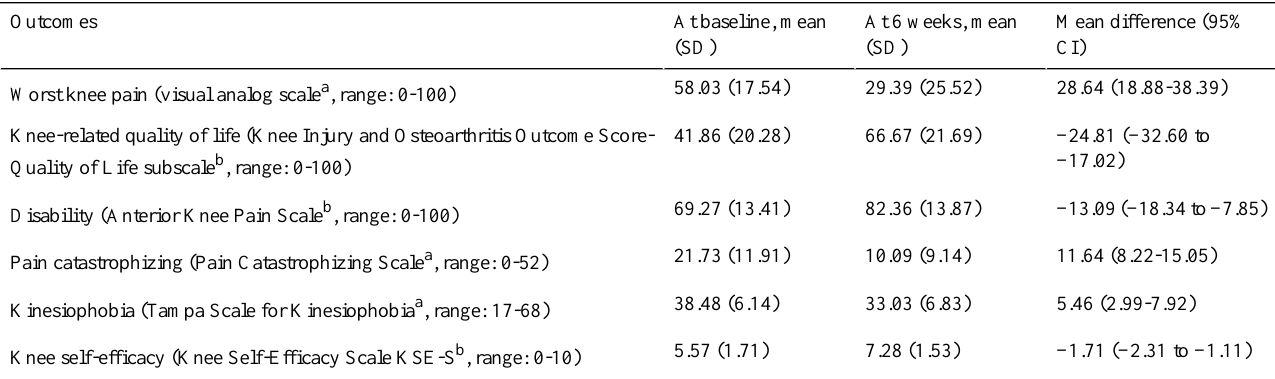
Table 1. Comparisons between patient-reported outcomes at baseline and after the 6-week self-directed web-based education and exercise therapy.